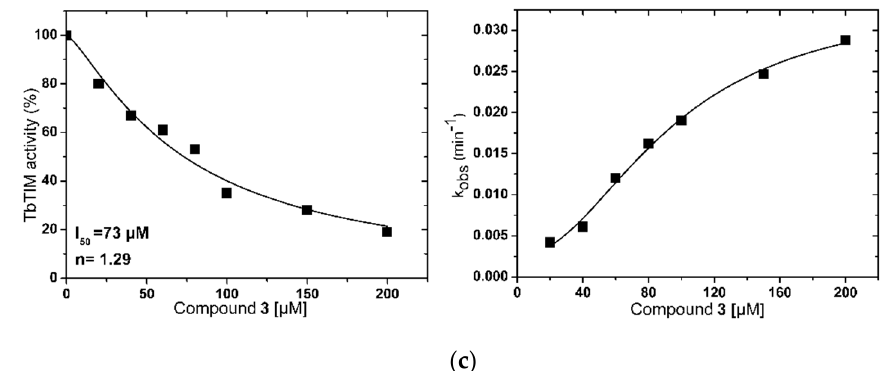
Figure 2. Activity of TbTIM (left panel) and plots of the pseudo-first-order rate constants (right panel) at different concentrations of compounds ( a ) 1 ; ( b ) 2 and ( c ) 3 . I 50 value was defined as the concentration of compound needed to reduce the enzymatic activity to 50% and determined through curves at different compound concentrations and a Hill coefficient, n , is a measure of the degree of cooperativity of the ligands.